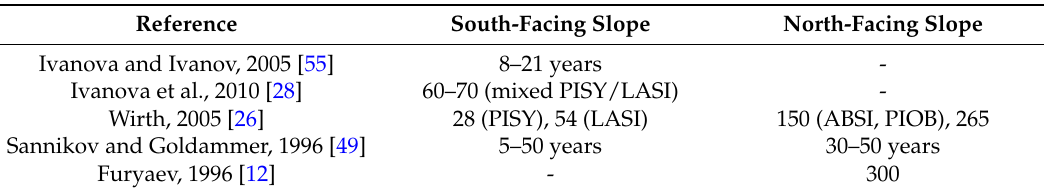
Table 2. Mean Fire Return Interval (MFRI) for north- and south-facing slopes in southern Siberia. We used MFRI of 40 years on the south-facing slopes and 200 years on the north-facing slopes. (PISY = Pinus sylvestris , LASI = Larix sibirica , ABSI = Abies sibirica , PIOB = Picea obovata ; see Table 1 for other species abbreviations).